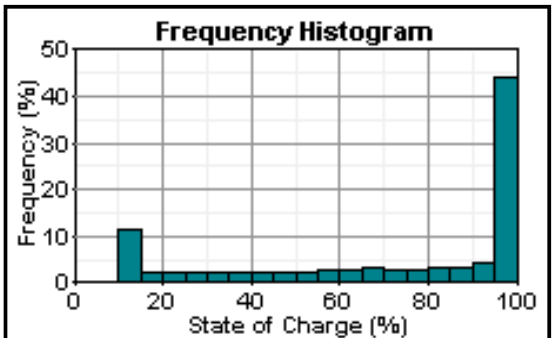
Figure 9. VRB state-of-charge frequency histogram.